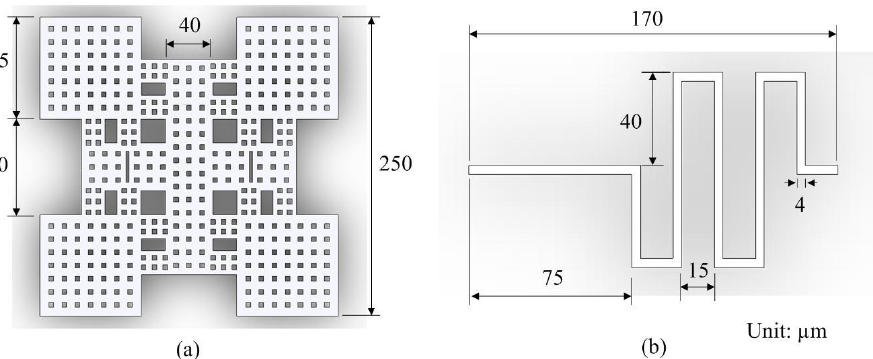
Figure 2. Dimensions of ( a ) membrane; and ( b )